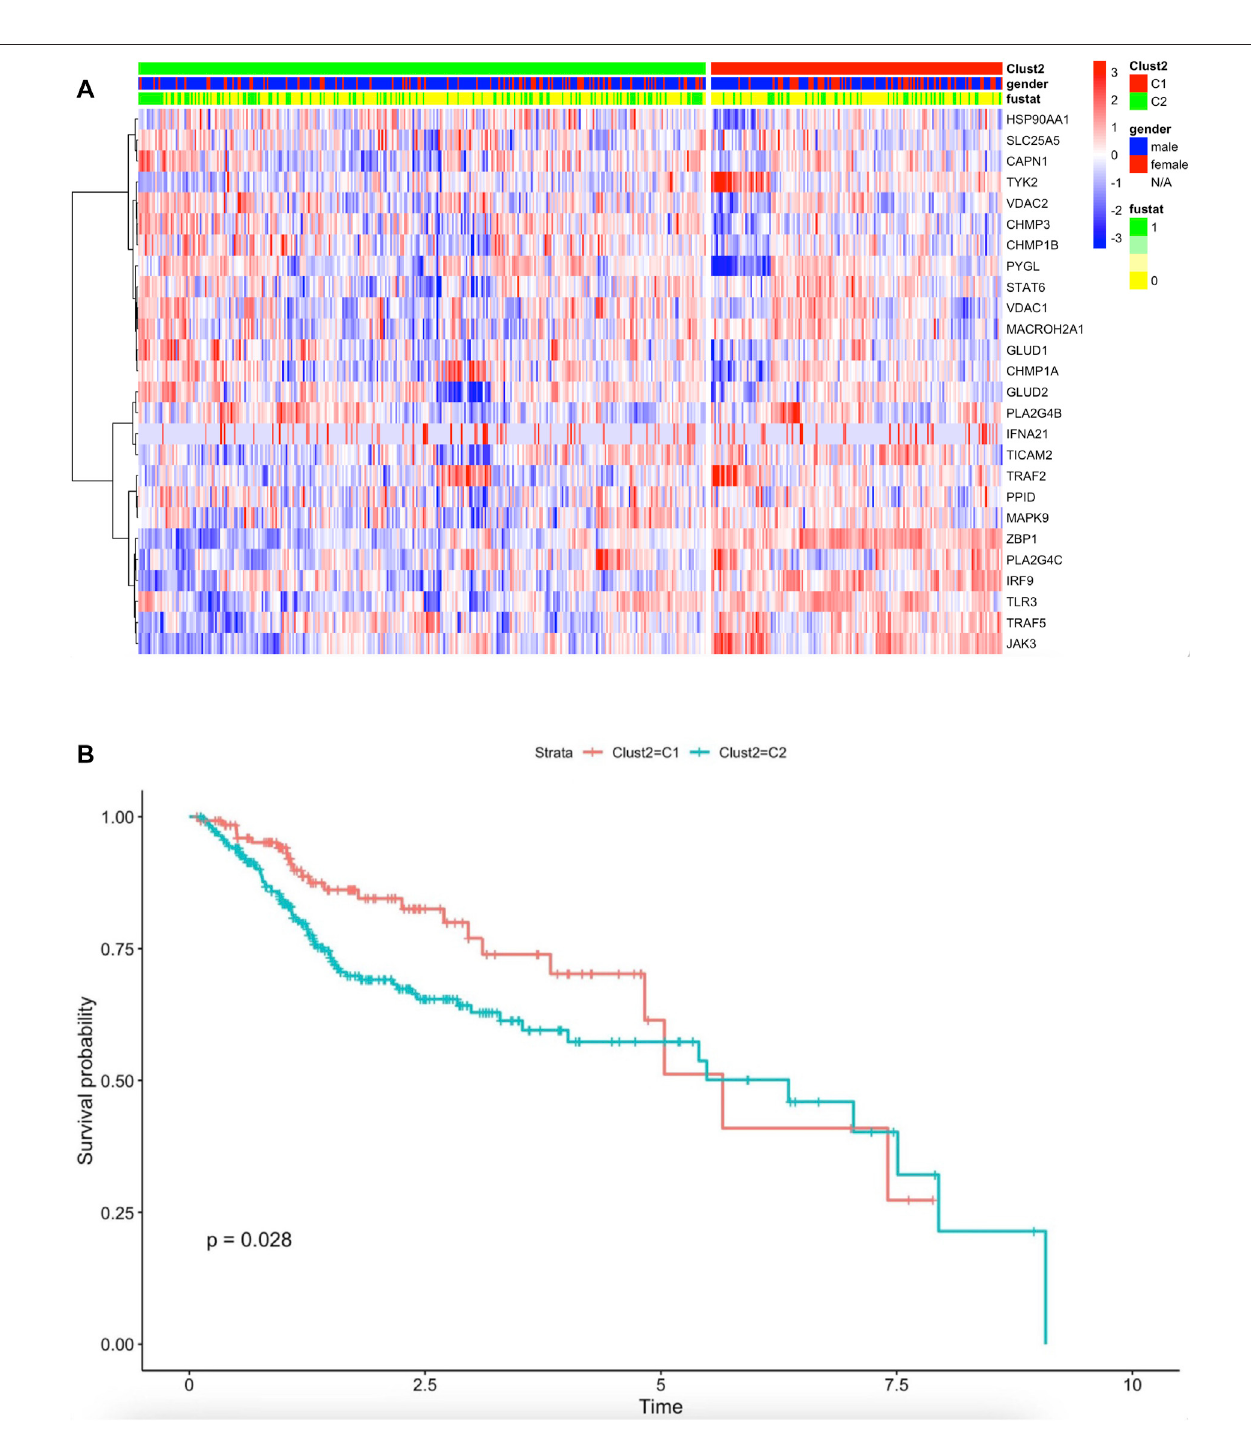
FIGURE2| TranscriptomeanalysisrevealednecroptosisisassociatedwithsurvivalinHNSCC. (A) Thesyntheticthermogramdisplaysthecorrelationbetweenthe twotypesofnecroptosisandtheexpressionvarianceofthe26necroptosis-relatedmolecules(Meta-cohort),C1(170cases),C2(331cases), “ 1 ” meansdead, “ 0 ” means alive, “ fustat ” means survival status. (B) The Kaplan-Meier plot displays signi fi cant differences of survival rate among the two kinds of necroptosis phenotypes in the TCGA database. C1 (131cases) was better than C2 (253cases). Unit of Time (years). (C) The GSE65858 Kaplan-Meier plot displays signi fi cant differences of survivalrate among the twokinds of necroptosis phenotypes. C1 (113cases) wasbetterthan C2(154cases). Unit ofTime (years). (D) Thewaterfallplot displays the nine necroptosis molecules somatic mutations with mutation frequency in HNSCC.